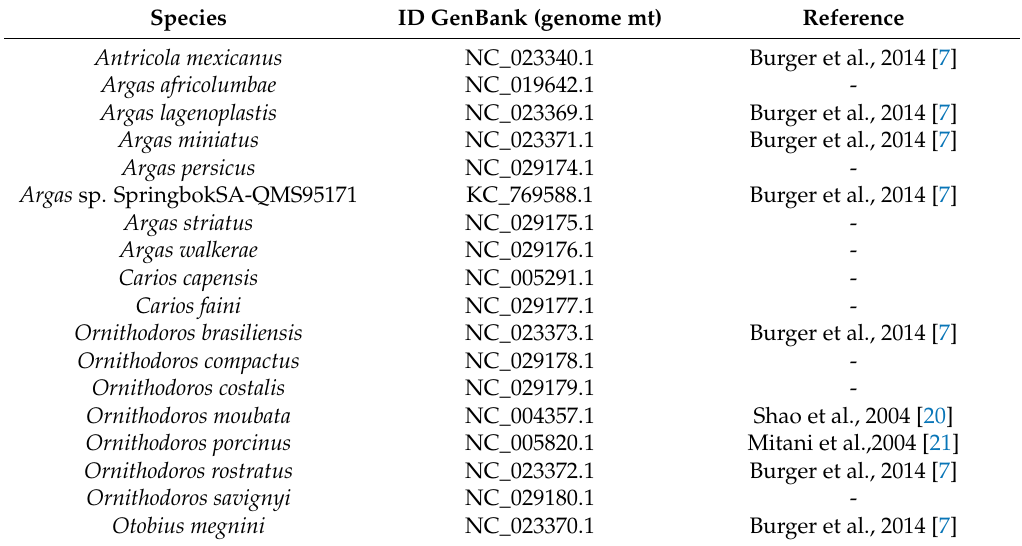
Table 1. Mitochondrial genomes of argasids selected for this